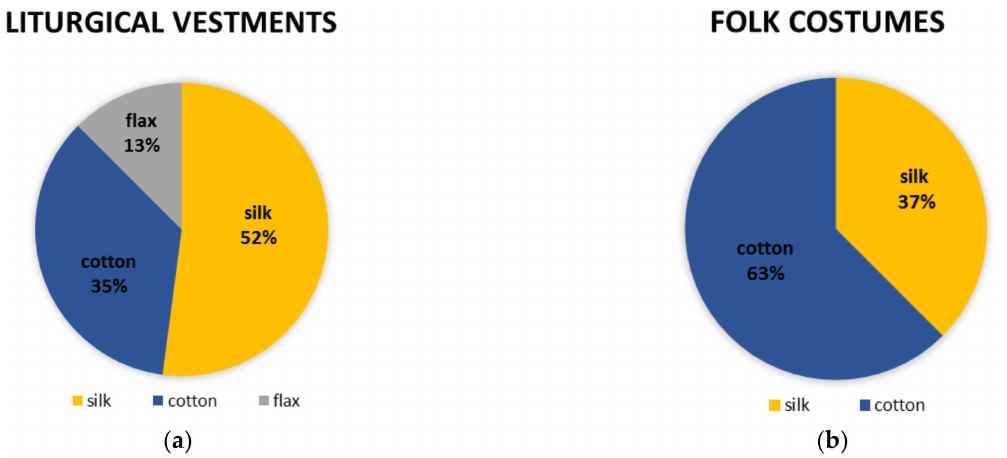
Figure 7. Compared textile yarns in combined metal textile threads ( a ) from liturgical vestments ( b ) from folk